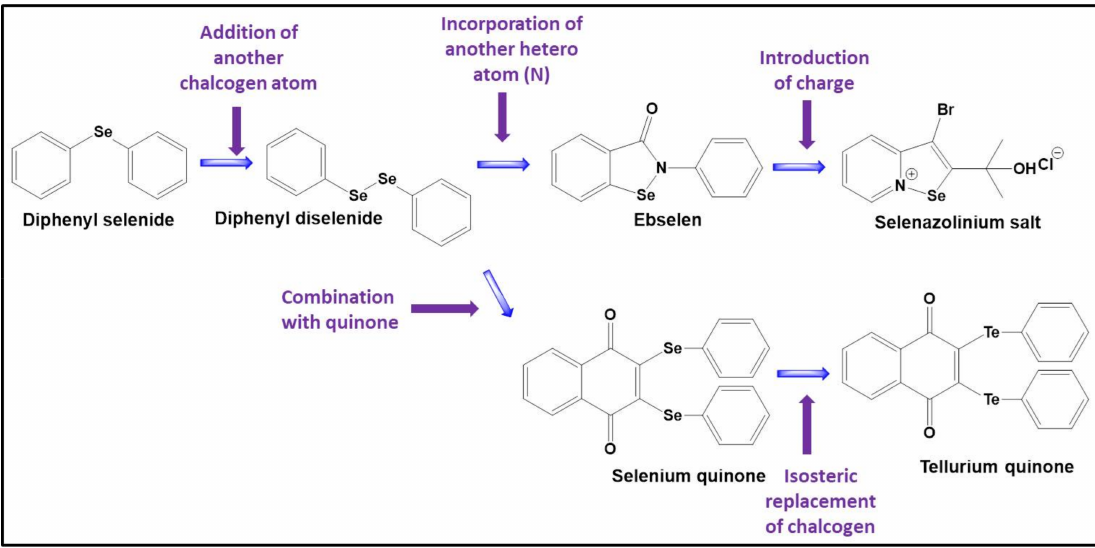
Figure 5. During the last couple of years, various strategies have been explored in order to increase the catalytic activity and selectivity of redox catalysts. See text for